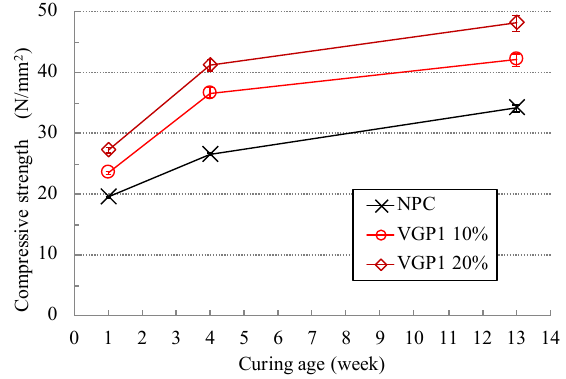
Figure 15. Compressive strength